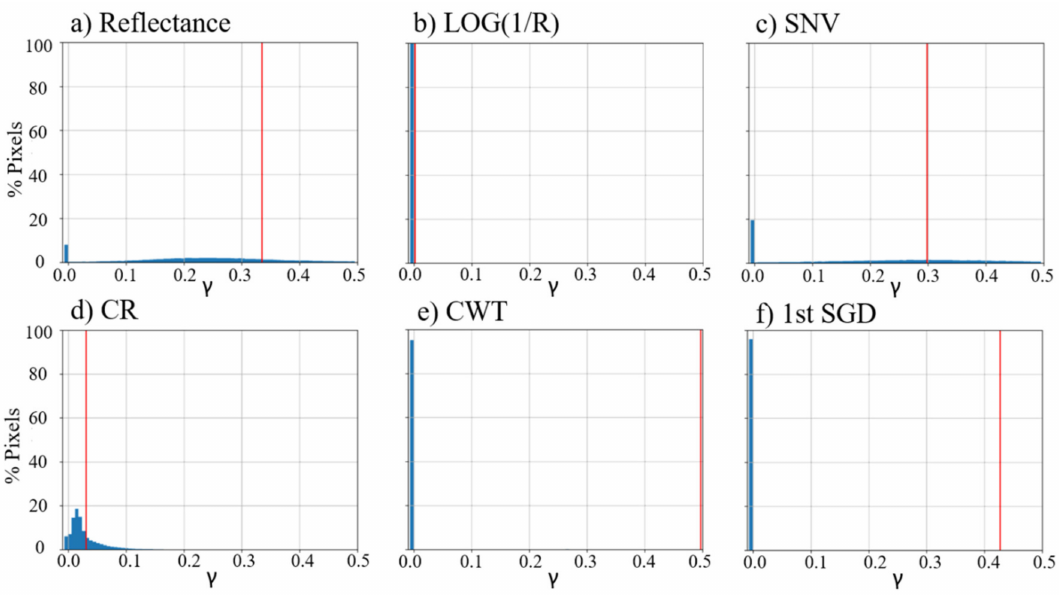
Figure 12. Histograms of parameter γ (non-linearity contribution of GBM) for MC mixtures: